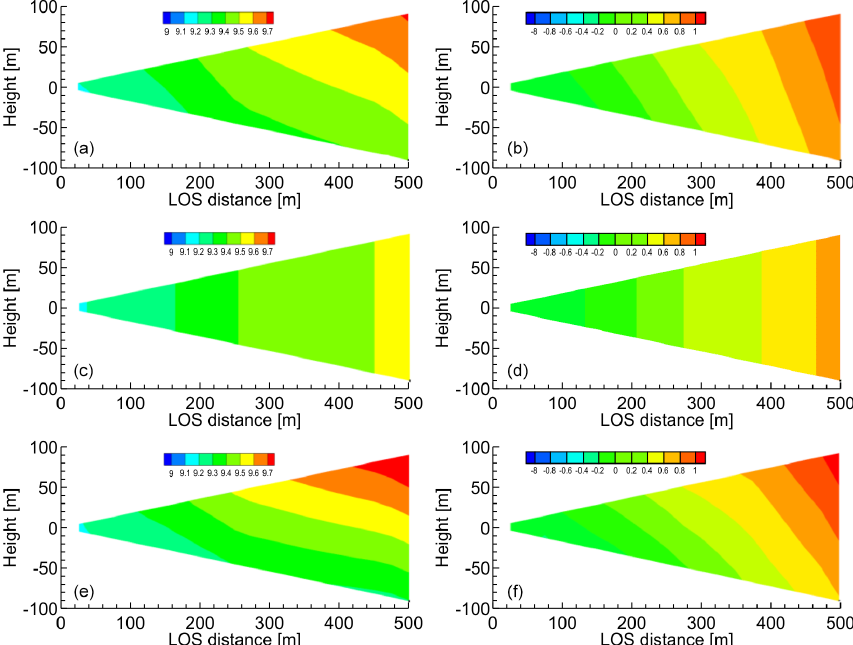
Figure 14. Distributions of horizontal and vertical wind components estimated via simple vector conversion and proposed method before approach to vertical wind fluctuation. (a, b) Ideal vortex model; (c, d) simple vector conversion method; (e, f) proposed method with five past LOS wind datasets. (a, c, e) Horizontal wind values; (b, d, f) vertical wind values.